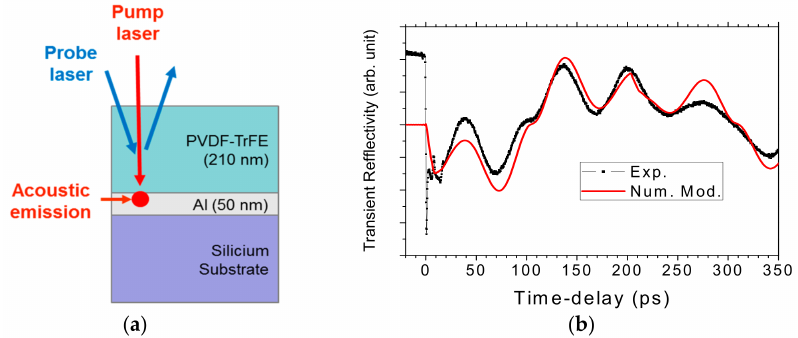
Figure 2. ( a ) Schematic cross section of the sample studied using the PU technique. ( b ) Measured transient optical reflectivity signal allowing for the detection of acoustic propagation (oscillation) and reflection at the free interface (reflectivity step near 105